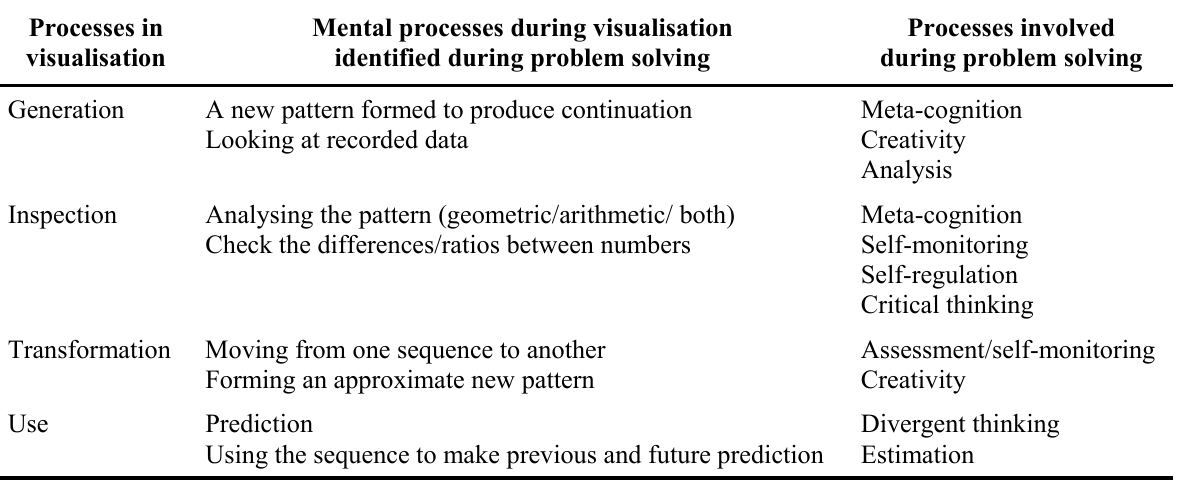
Table 2 : Results of Task